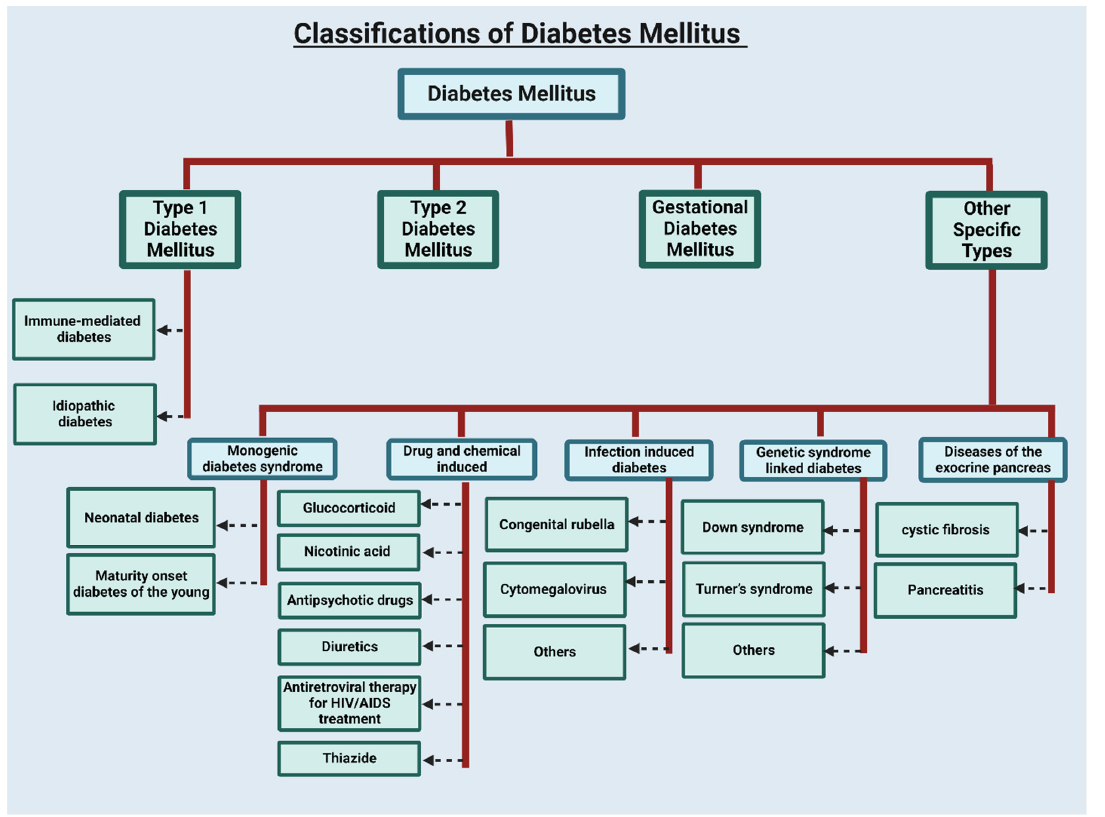
Figure 1. Classification of diabetes mellitus. Generally, diabetes can be categorized into four catego ‐ ries. Created with BioRender.com. gories. Created with